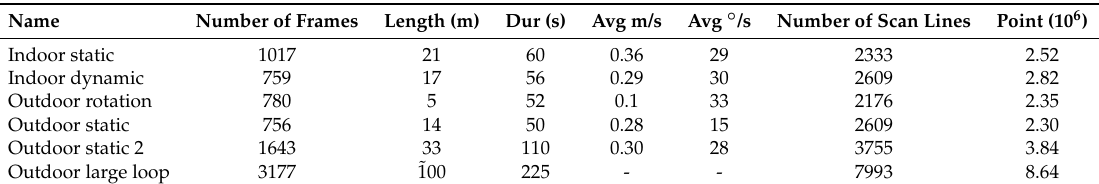
Table 3. Trajectory statistics: all are rounded and are supposed to give a rough impression of the trajectory characteristics. Depicted are the number of frames, the length in meters, the duration in seconds, and the average translation and rotation velocity. We omit some statistics for the trajectory Outdoor large loop , because most parts of the trajectory are outside the tracking volume of the motion capture system.